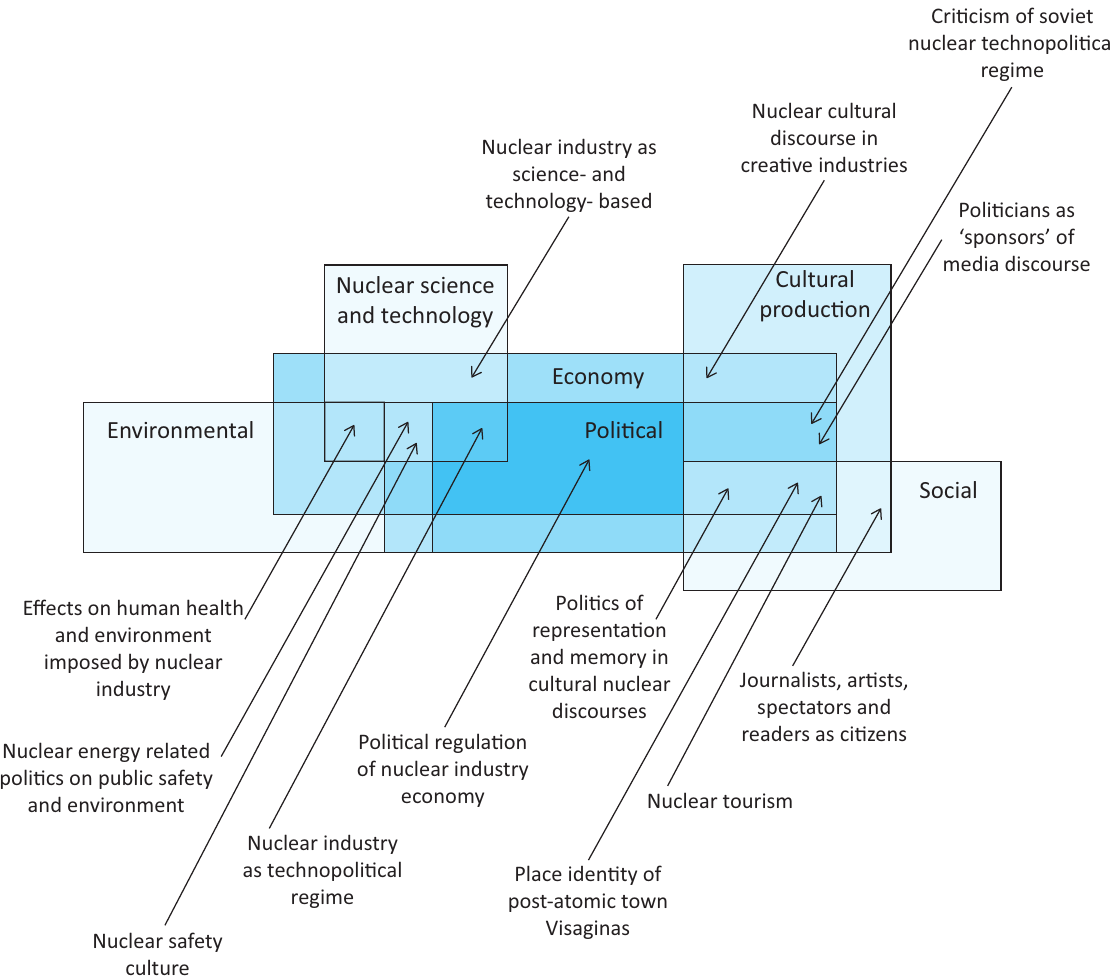
Figure 2. Main interacting fields involved into construction of nuclear media discourses: Findings of analysis of Lithuanian online media portals in